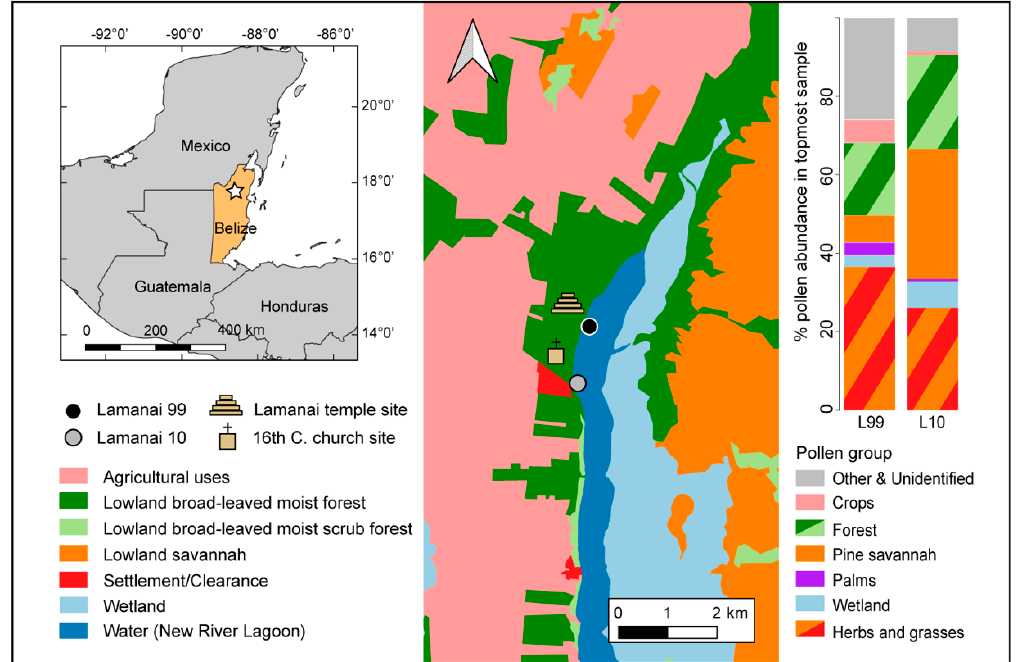
Figure 1. Location of the Lamanai-99 (black circle, 16Q 324951 E, 1964889 N) and Lamanai-10 (grey circle, 16Q 324746 E, 1963519 N) sediment cores relative to Maya and post-colonial settlement of Indian Church (northernmost red cleared area) along the western shore of NRL. Landcover classifications were obtained from Meerman and Sabido (2011). Inset: Location of the study region (Lamanai) in northern Belize.